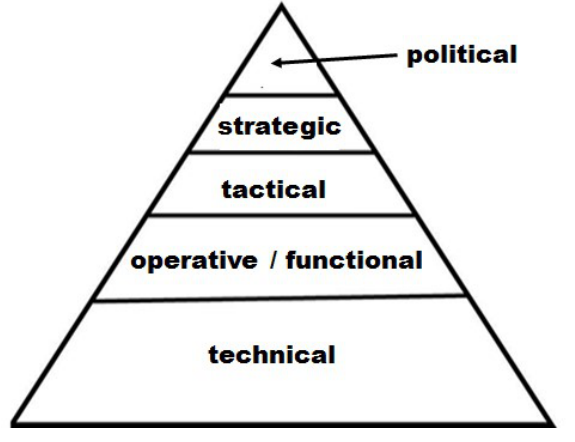
Figure 3. Levels of safety management [3] [4] [5].